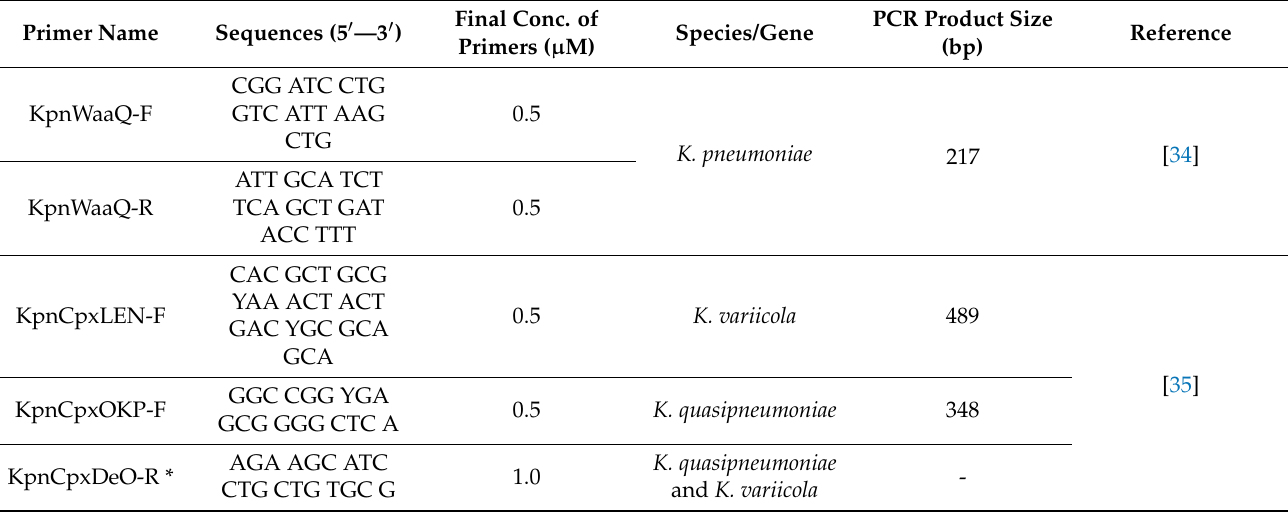
Table 2. Primers used for detection of antibiotic resistance